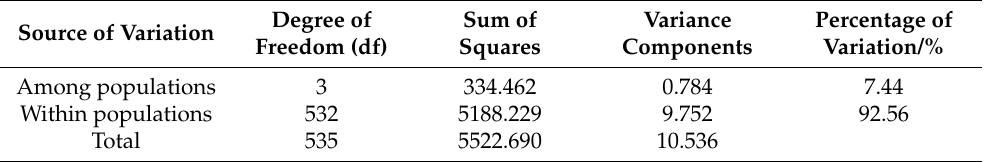
Table 5. The genetic distance ( D ) (below ‐ diagonal) and genetic differentiation index ( F st ) (above ‐ diagonal) of four P. fluviatilis populations.